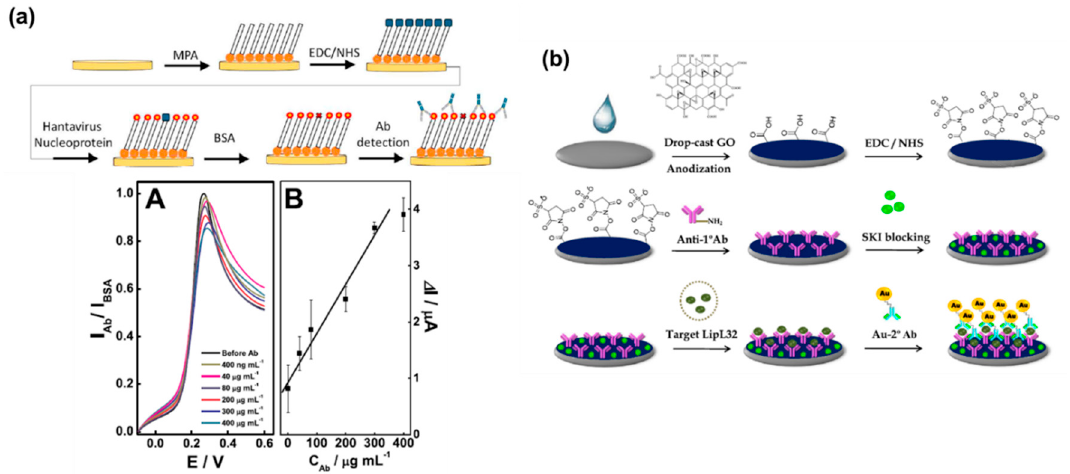
Figure 5. Label-free and sandwich type immunosensor fabrication process. ( a ) Label-free immunosensor preparation through antibody immobilization for the detection of hantavirus [73]. ( b ) Schematic representation of the sandwich type electrochemical immunosensor fabrication process for